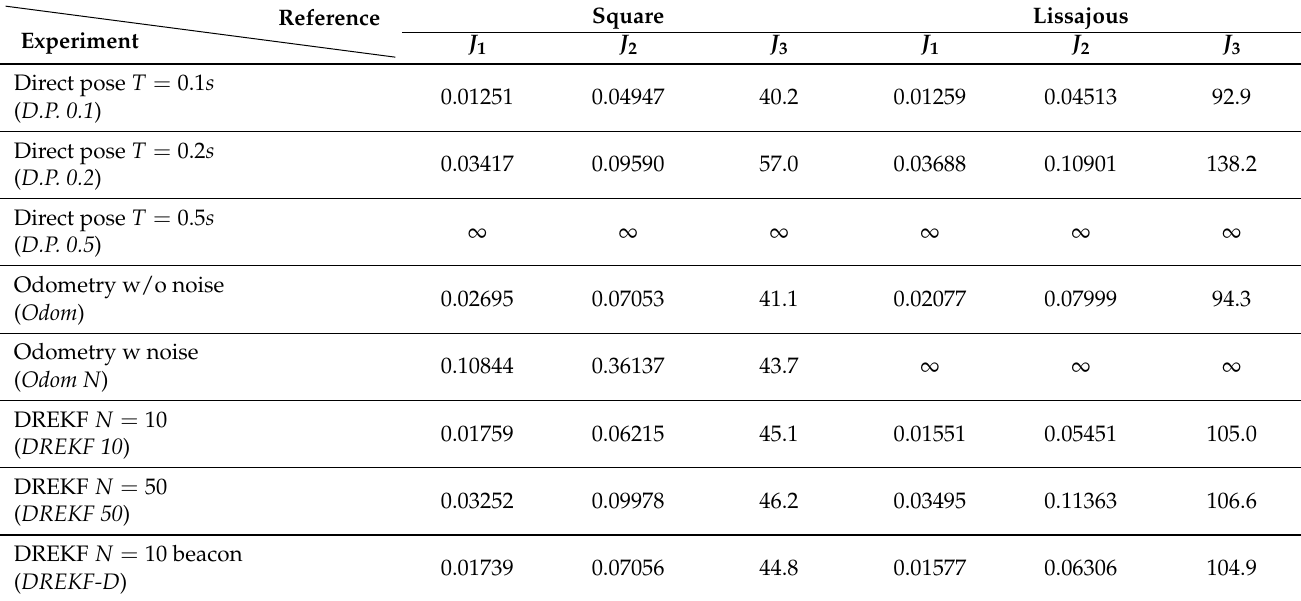
Table 3. Cost index